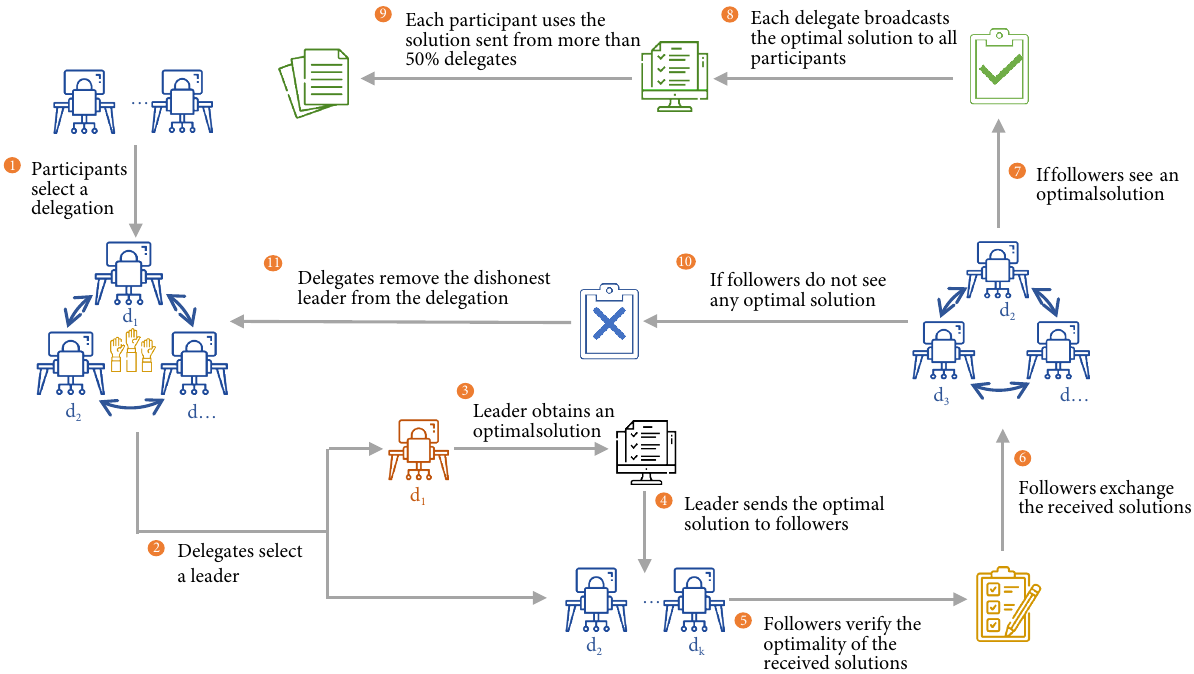
Fig. 1 PoSo flowchart (reprinted with permission from Nature Energy, 7: 495–502, 2022, © The Author(s), under exclusive licence to Springer Nature Limited